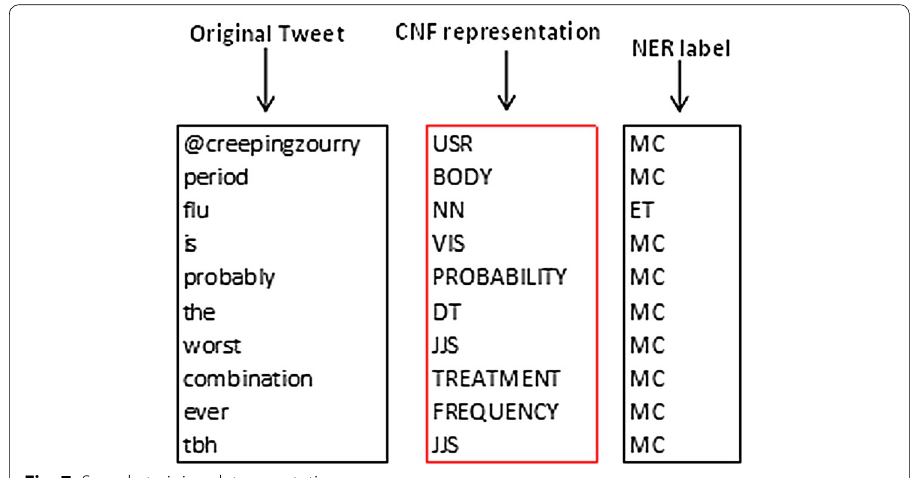
Fig. 7 Sample training data